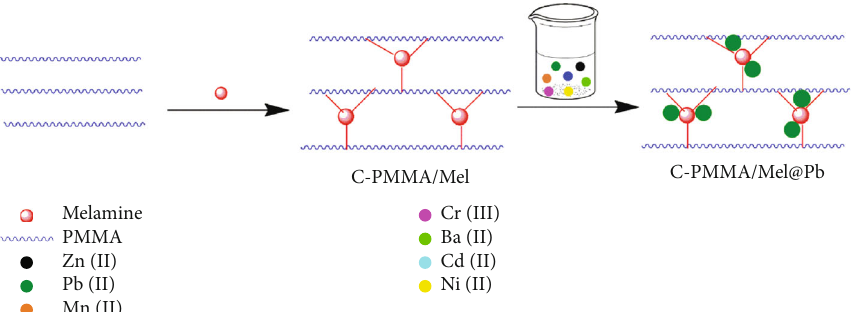
Figure 5: Schematic illustrations of the newly synthesized C-PMMA/Mel on the removal of